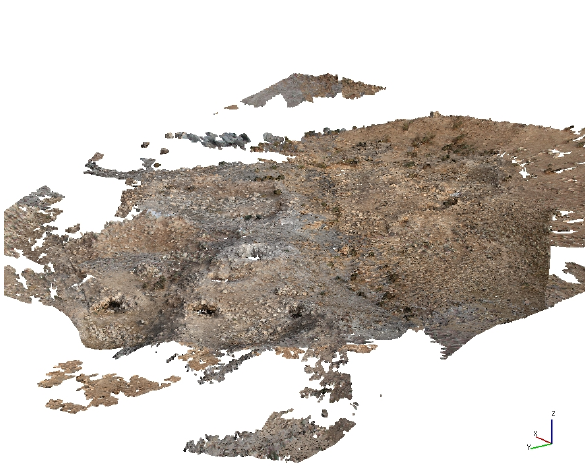
Figure 10. Overview of point cloud